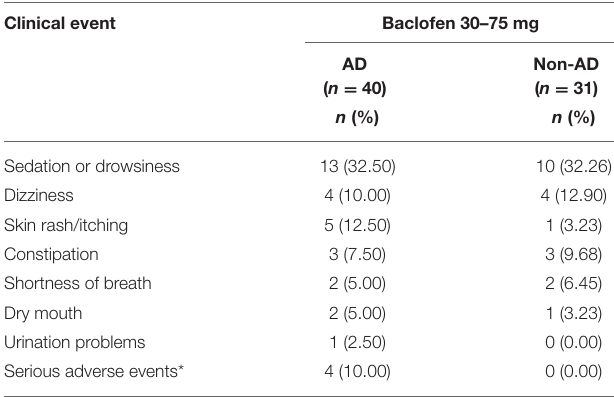
TABLE 4 | Side effect profile of subjects treated with either baclofen (30–75mg) or placebo and concurrent antidepressant use. Clinical